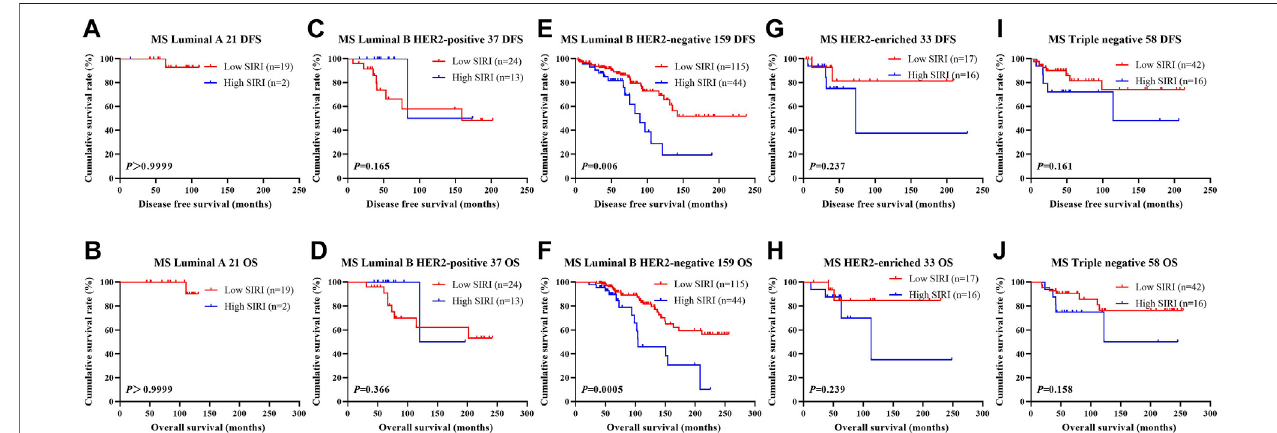
FIGURE 5 | DFS and OS based on SIRI scoresin patients with breast cancer ofvarious molecular subtype (Non-NACT group). DFS and OS based on SIRI scores in patientswithbreastcancerofvariousmolecularsubtype(Non-NACTgroup). (A) Kaplan-MeieranalysisofDFSfortheSIRIofpatientswithluminalAbreastcancer. (B) Kaplan- MeieranalysisofOSfortheSIRIofpatientswithluminalAbreastcancer. (C) Kaplan-MeieranalysisofDFSfortheSIRIofpatientswithluminalBHER2-positivebreastcancer. (D) Kaplan-MeieranalysisofOSfortheSIRIofpatientswithluminalBHER2-positivebreastcancer. (E) Kaplan-MeieranalysisofDFSfortheSIRIofpatientswithluminal BHER2-negativebreastcancer. (F) Kaplan-MeieranalysisofOSfortheSIRIofpatientswithluminalBHER2-negativebreastcancer. (G) Kaplan-MeieranalysisofDFSforthe SIRIofpatientswithHER2-overexpressingbreastcancer. (H) Kaplan-MeieranalysisofOSfortheSIRIofpatientswithHER2-overexpressingbreastcancer. (I) Kaplan-Meier analysis of DFS for the SIRI of patients with triple-negative breast cancer. (J) Kaplan-Meier analysis of OS for the SIRI of patients with triple-negative breast